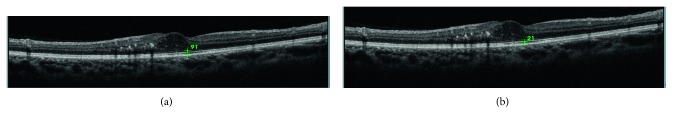
Diabetic patient with BCVA 20/60 (0.5 logMAR). Central subfield thickness is 378 µm, ORL thickness is 91 µm, and PROS length is 21 µm.